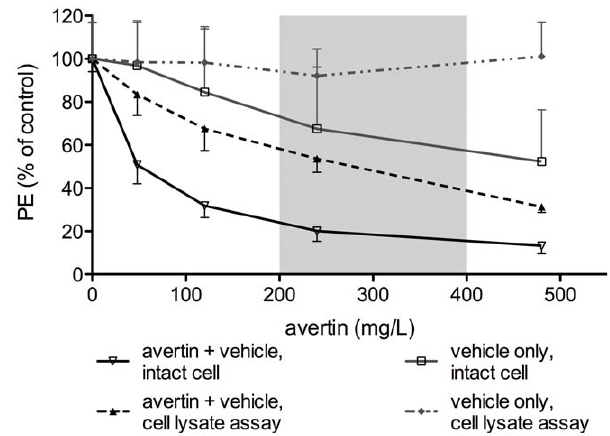
Figure 4. Effect of avertin and its vehicle on BLI signal of intact cells and cell lysates. The effect on photon emission (PE) of the anesthetic avertin (black) and its vehicle 2-methyl-2-butanol (grey) are shown using intact cells (full line) and cell lysates (dotted line). All data are represented as mean % of control (absence of anesthetic) 6 SD. The grey interval in the curve indicates the concentration used in vivo , as reported in literature for mice.